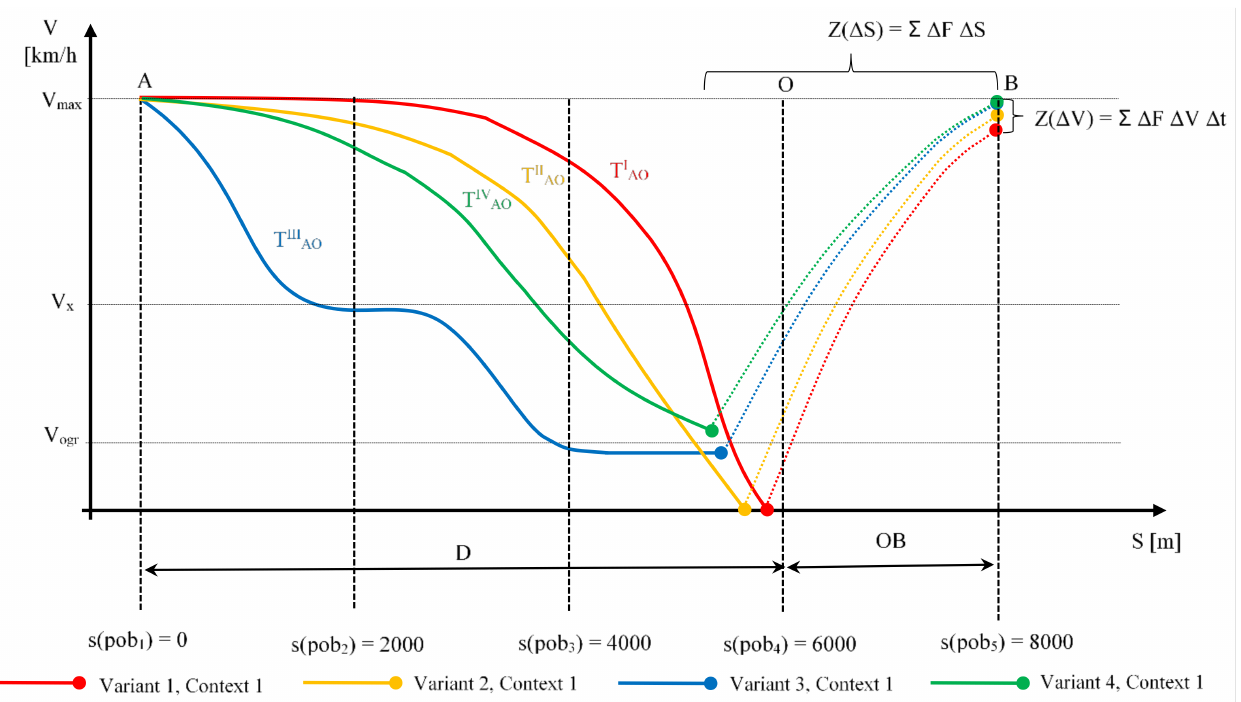
Figure 7. Sample standardization of the obtained results for context 1 (source: own